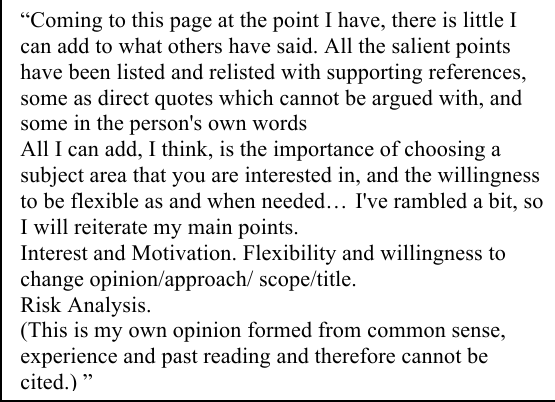
Figure 4. Critical thinking through in depth explanation of a